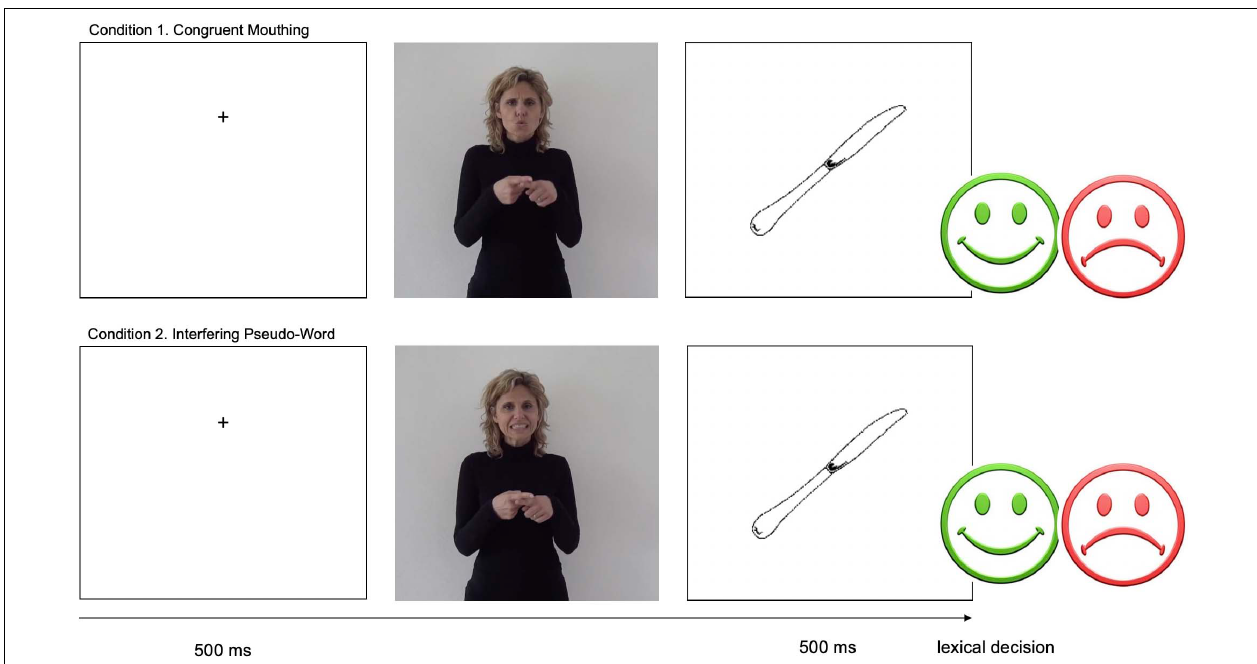
FIGURE 1 | Flow chart for the lexical decision experiment. In the control condition, the congruent mouthing/kuto/feats with manual sign COUTEAU (/na I f/ KNIFE ). In * Pseudo-Word condition, a pseudoword is presented with the manual sign KNIFE . In both conditions, participants have to decide if the picture matches the sign presented before it. All items are listed in the Supplementary Table 1 .